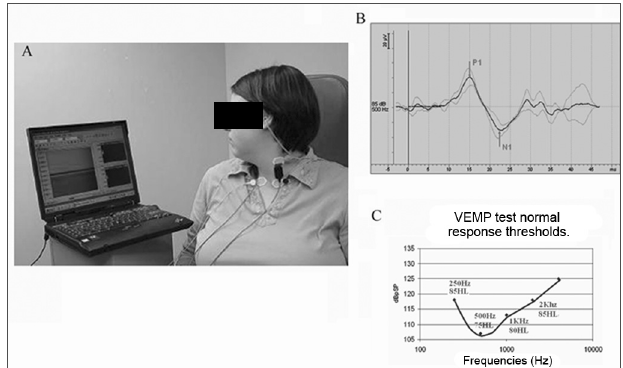
Figure 2a. VEMP test on the left side with earbud phones and elec- trodes placed on the SCM. The patients are placed on a comfortable chair and are instructed to turn their heads to the direction contrary to that of the sound stimulus, so as to have SCM muscle contraction to the ipsilateral side of the sound stimulus. Figure 2b. VEMP typical wave in a normal patient. Showing the first positive wave (P1) around 13ms and the second negative wave (N1) around 23ms. Figure 2c. Typical VEMP curve in a normal patient, showing the res- ponse threshold of the main frequencies